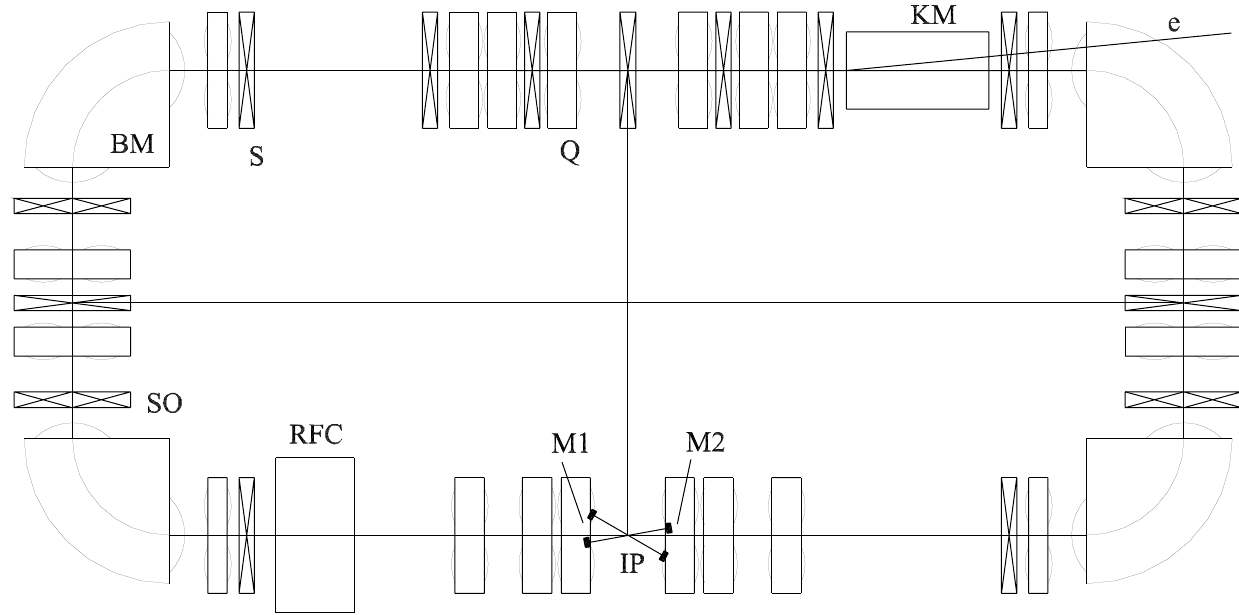
FIG. 1. LESR layout. IP is the interaction point, BM the bending magnets, Q, S, SO the quadrupole, sextupole, and combined sextupole and octupole lenses, correspondingly, RFC the rf cavity, KM the injection kicker magnet, M1-M2 the mirrors of the optical